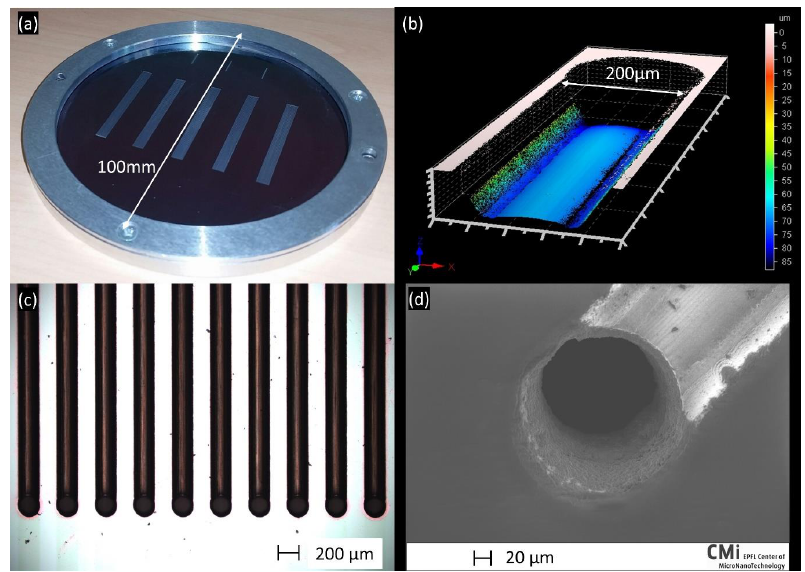
Figure 9. Results of laser-fabricated microchannels with through-holes at the extremities. ( a ) Photograph of the processed silicon wafer in its annular sample holder, ( b ) Confocal microscope image showing the morphology of a channel at its extremity, ( c ) Optical microscope image of the 10 microchannels with their through-holes at the bottom and ( d ) SEM picture of the hole and the channel.